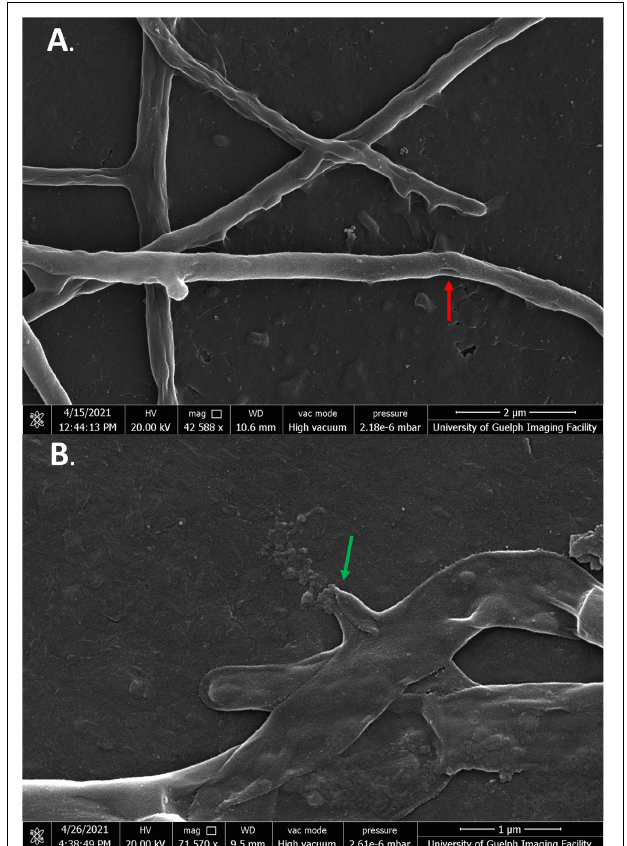
FIGURE 6 | SEM images of S. scabies grown in the presence of SG. (A,B) S. scabies was grown overnight in nutrient broth with 4% DMSO and SG at its MIC with a metal spring for shearing. The red arrow points to hole in the membrane of a cell. The green arrow points to a cell spewing its contents. Images were taken via a Quanta 250 FEG SEM (FEI company, OR, United